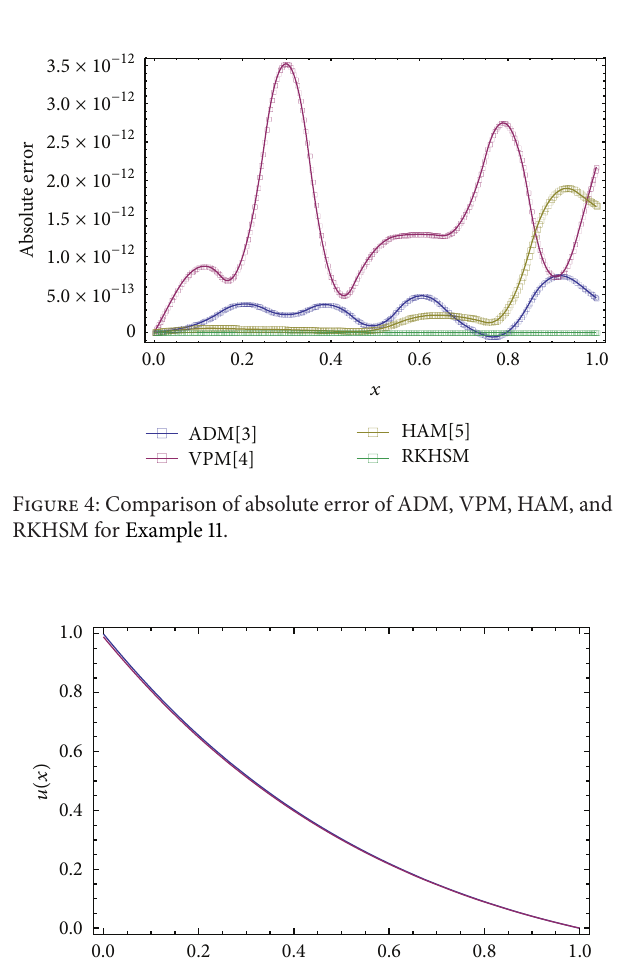
Figure 6: Comparison of absolute error of ADM, HAM, and RKHSM for Example